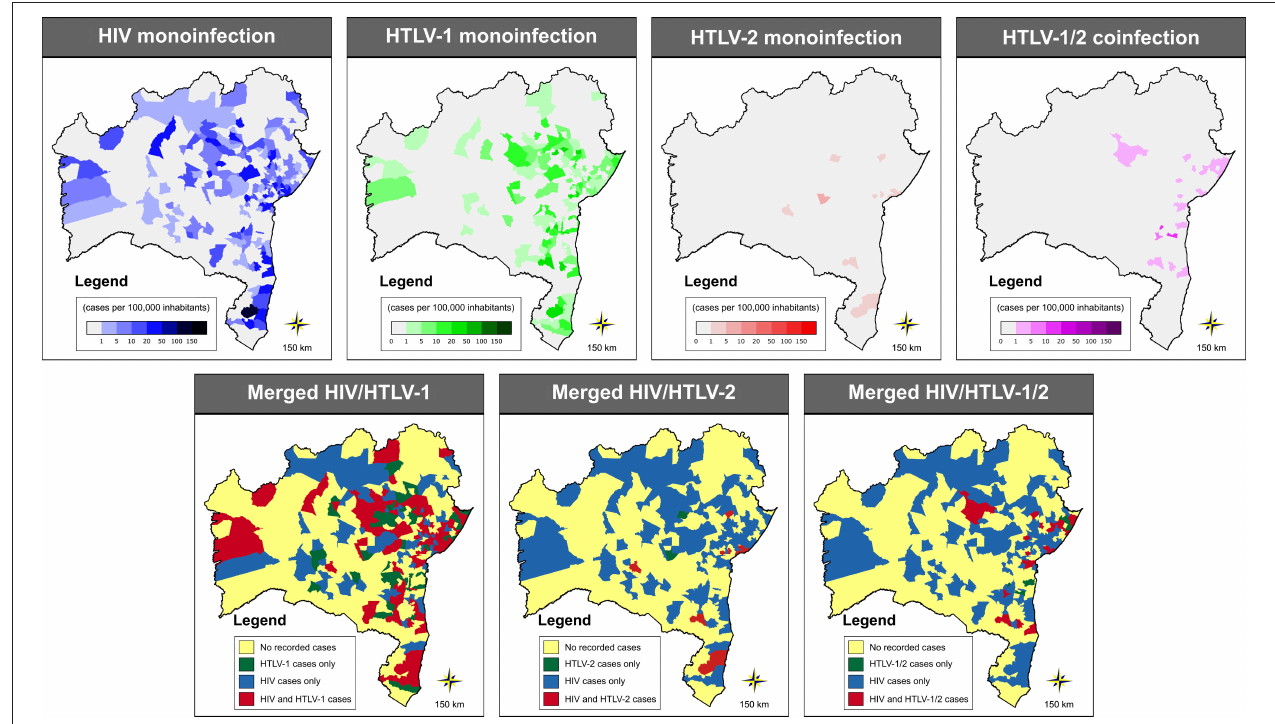
FIGURE 4 | Geographic distribution of cases of HIV-1, HTLV-1, HTLV-2 and HTLV-1/2, as well as merged graphs detailing the distribution of two or more of these infections, throughout the municipalities in the state of Bahia (2004–2013). Public domain digital maps were obtained in shapefile format (.shp), subsequently reformatted and analyzed using QGIS version 3.10 (Geographic Information System, Open-Source Geospatial Foundation Project.